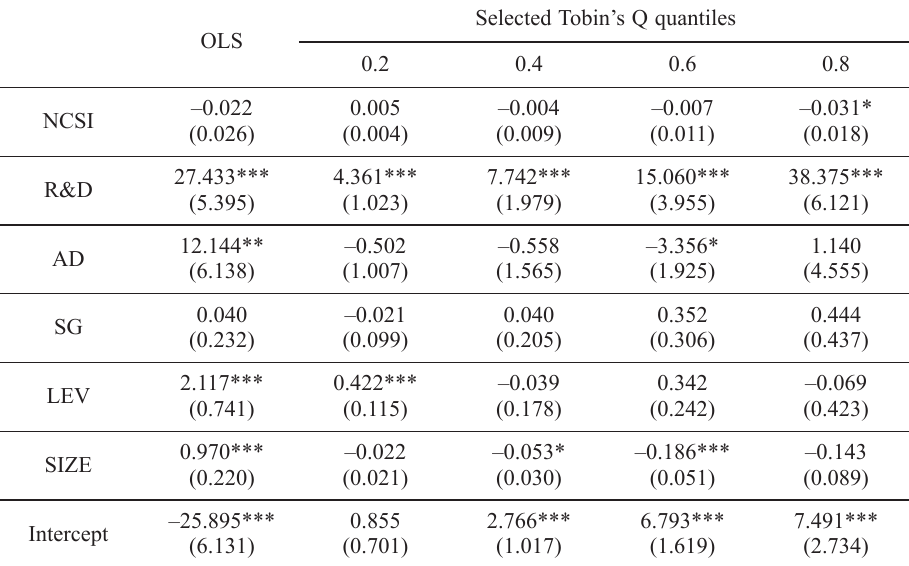
Table 2. The effects of customer satisfaction on firm